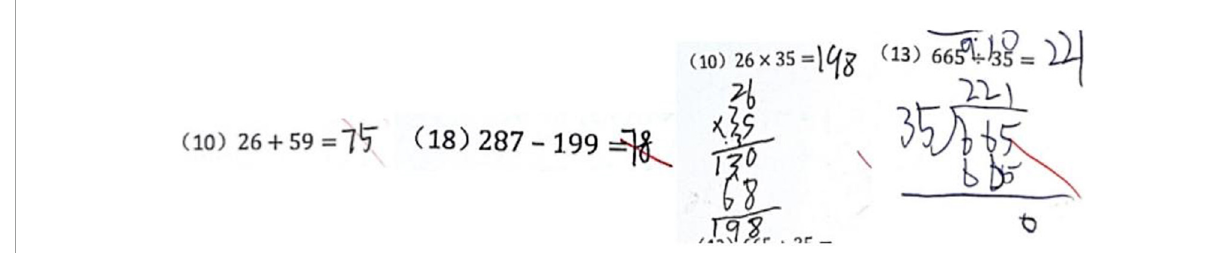
FIGURE3 Reminding error, debit error, spatial arrangement error, failure to consider divisor as a whole.